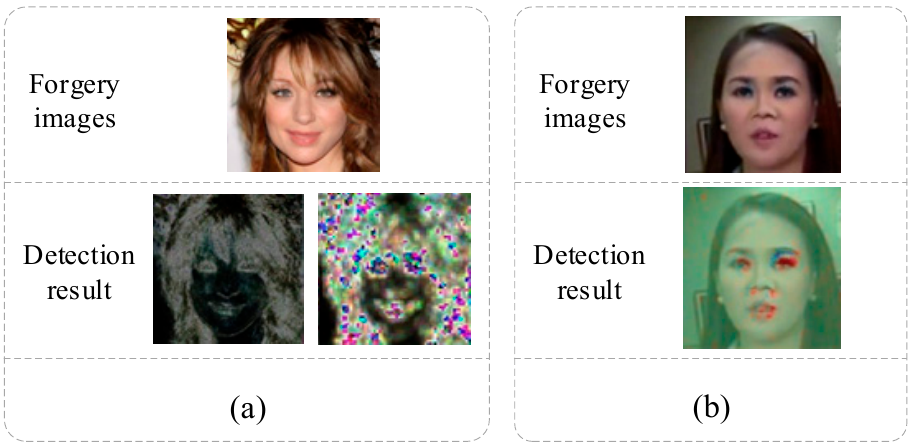
Figure 2. The feature visualization of [41,44]. ( a ) Pixel-level (left) and Stage 5-level (right). ( b ) Resid- ual guided attention model.